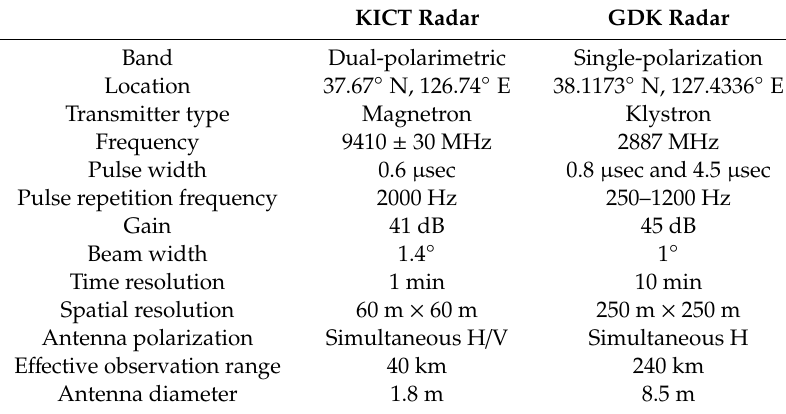
Table 1. Technical specification of radars.